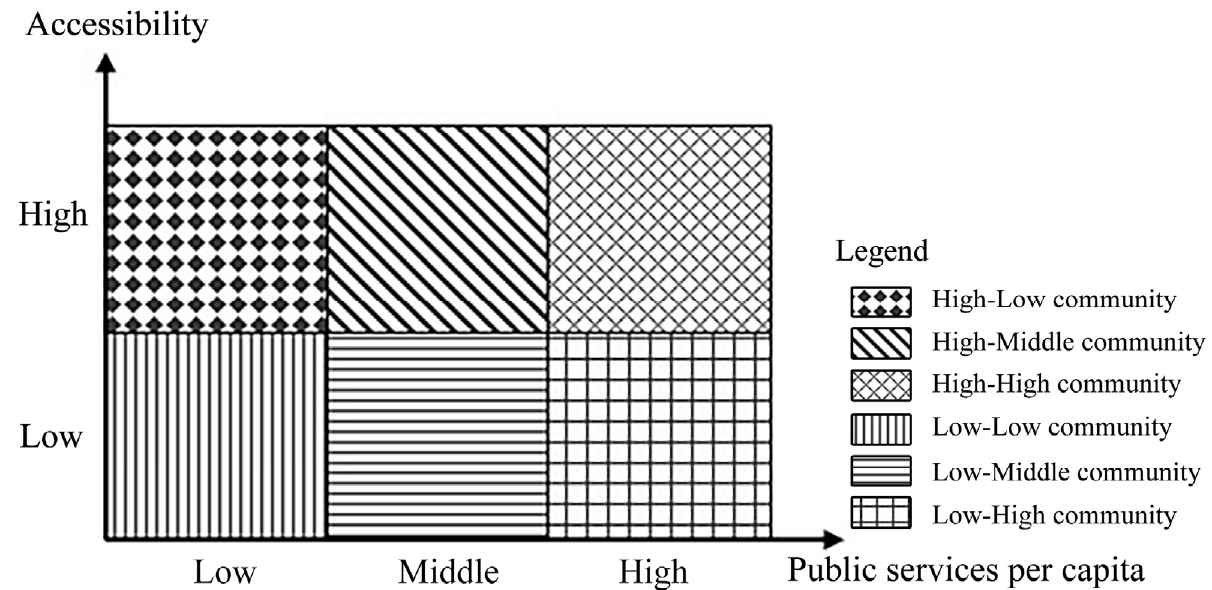
Figure 4. Classification of typical residential space. Public service per capita is the reciprocal of population carrying pressure.